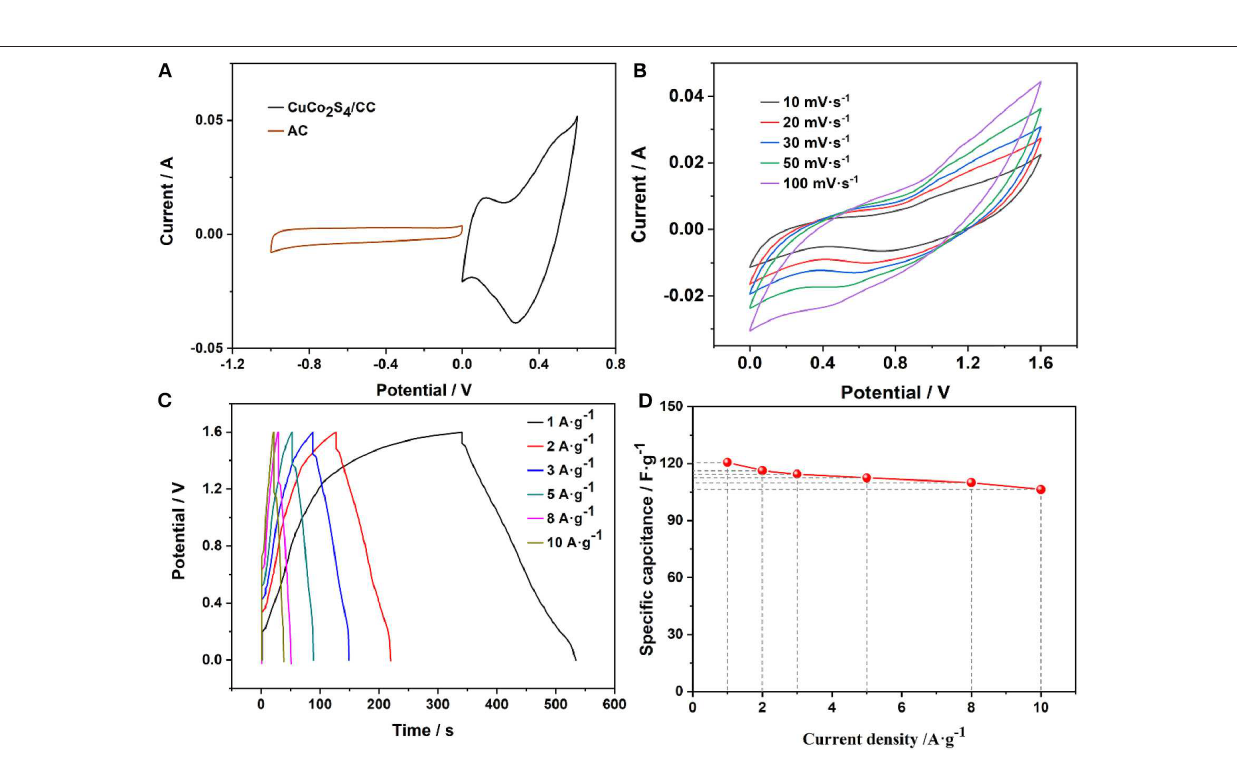
Frontiers in Chemistry |